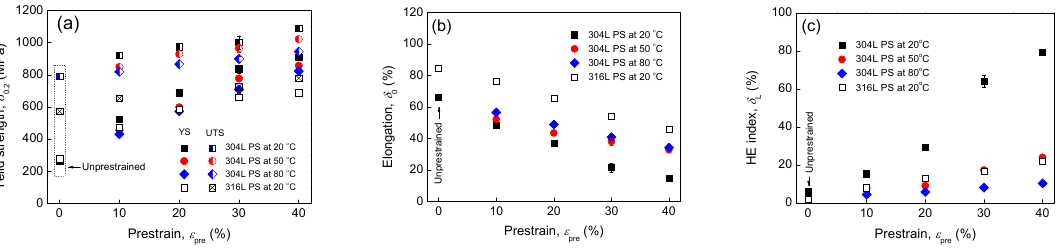
Figure 6. Yield strength ( a ), total elongation ( b ), and HE index ( c ) of un-prestrained and prestrained (PS) specimens as functions of prestrain level and temperature.